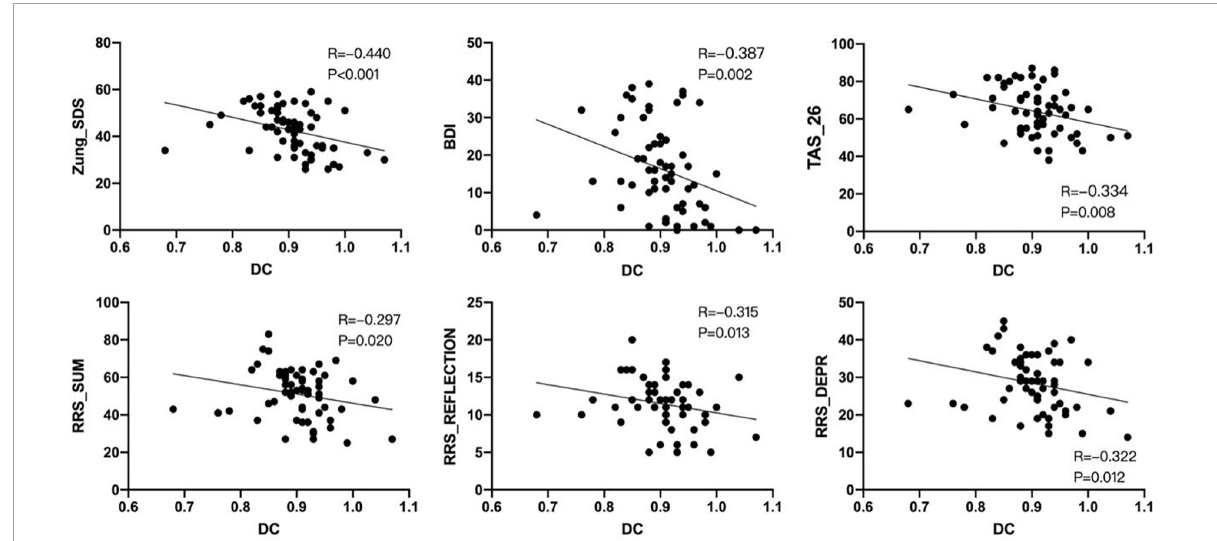
FIGURE3 Non-parametric test–Spearman correlation analysis showed that the degree centrality (DC) signal of the left insula was negatively correlated with Zung_SDS, BDI, TAS_26, RRS_SUM, RRS_REFLECTION, and RRS_DEPR scores in the mild to moderate depression group ( P < 0.05). • Means the degree centrality of each subject in the left insula.